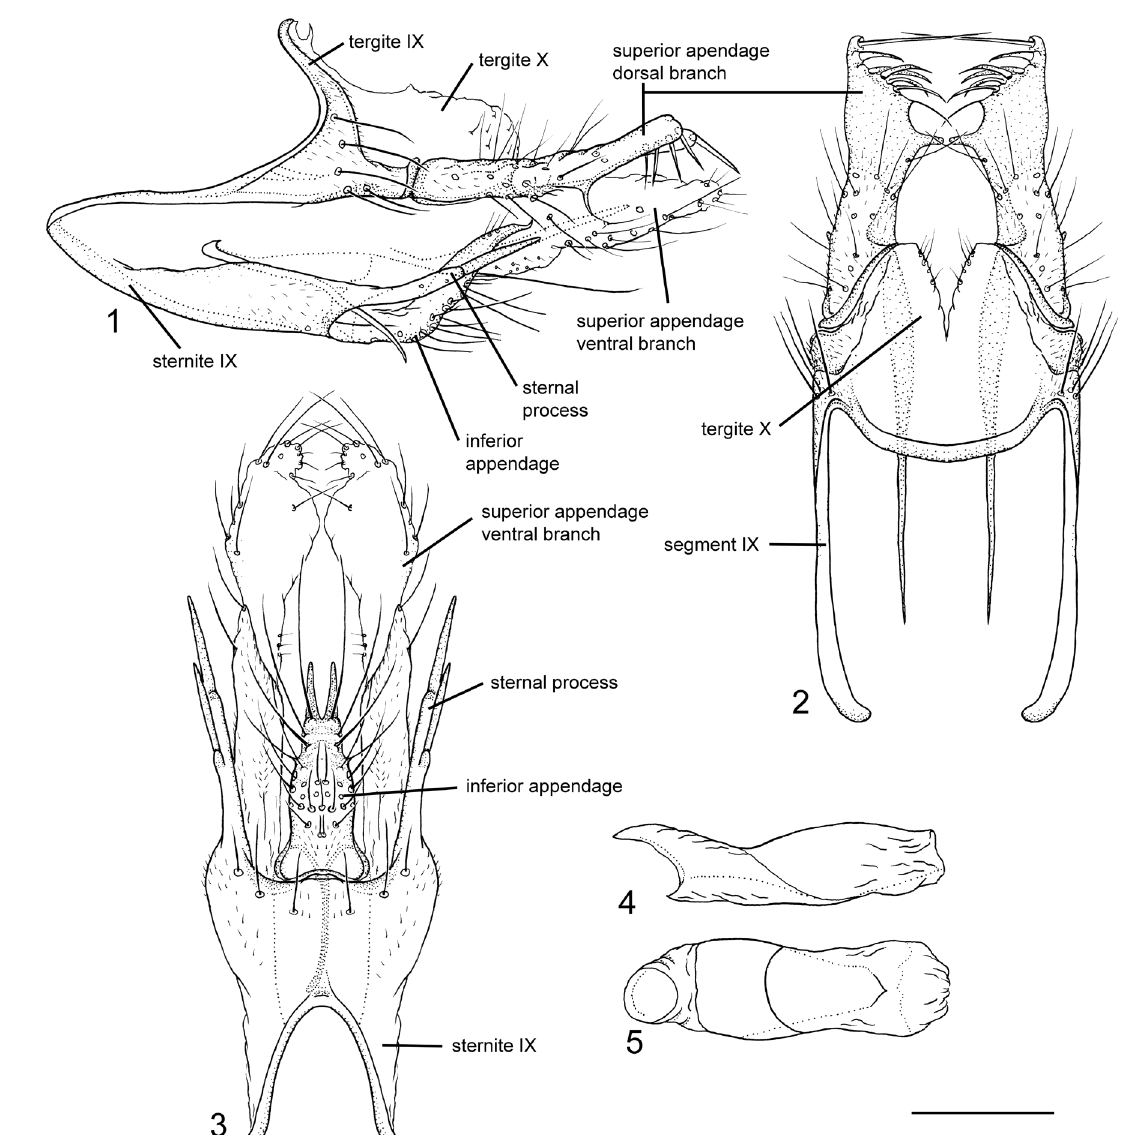
Figs 1–5. Caledomina paniensis sp. nov., holotype, adult ♂. 1 . Genitalia, lateral view. 2 . Genitalia dorsal view. 3 . Genitalia, ventral view. 4 . Phallus, lateral view. 5 . Phallus ventral view. Scale bar = 0.1